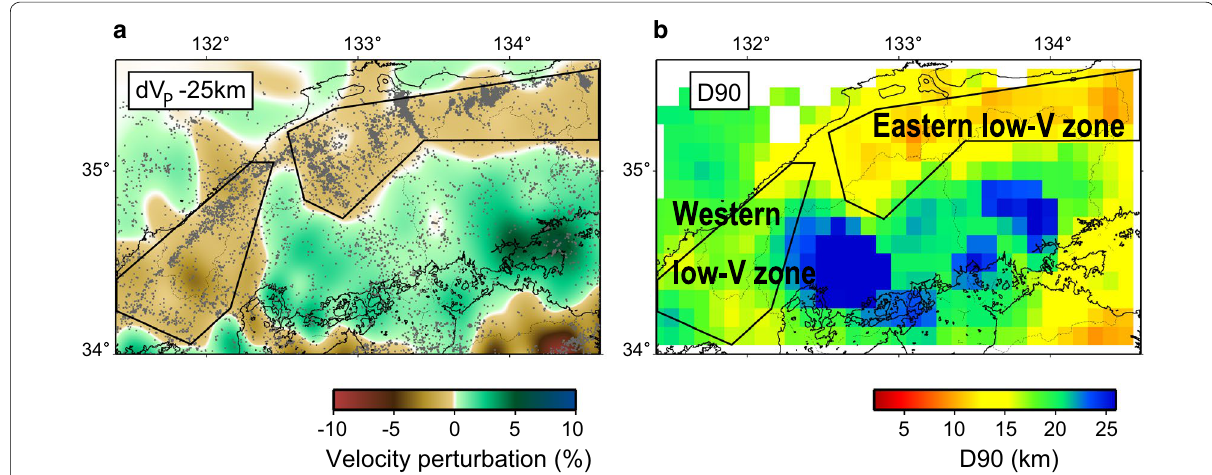
Fig. 5 a P-wave velocity perturbations at a depth of 25 km. Velocity perturbations are deviations from the initial velocity. Gray dots denote epicenters of intraplate earthquakes of M J 1.0 and depths 20 km that occurred between January 2001 and December 2016. b Distribution of ≥ ≤ D90. Colors represent the depth of the